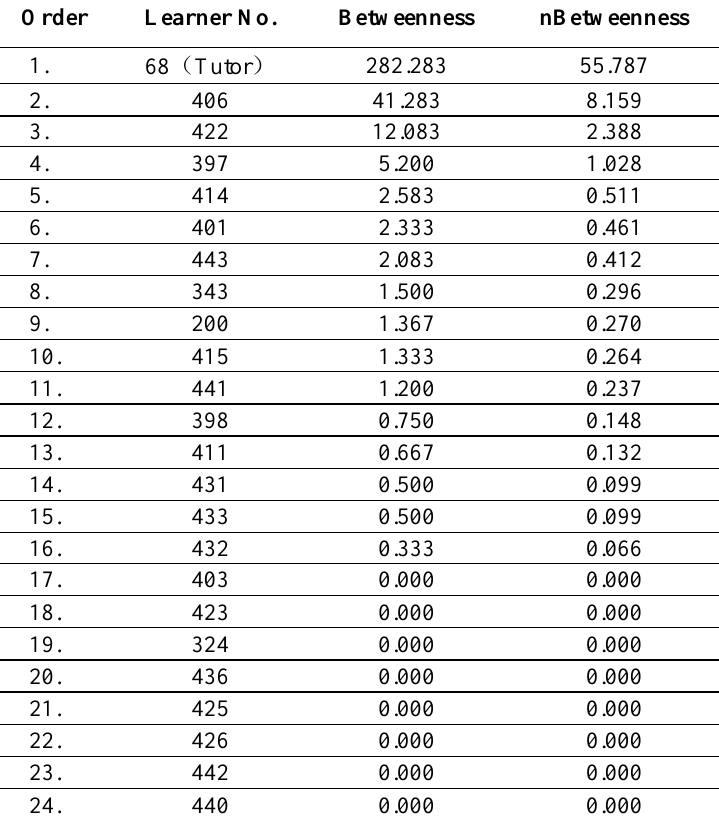
Betweenness centrality of learners in NITL Order Learner